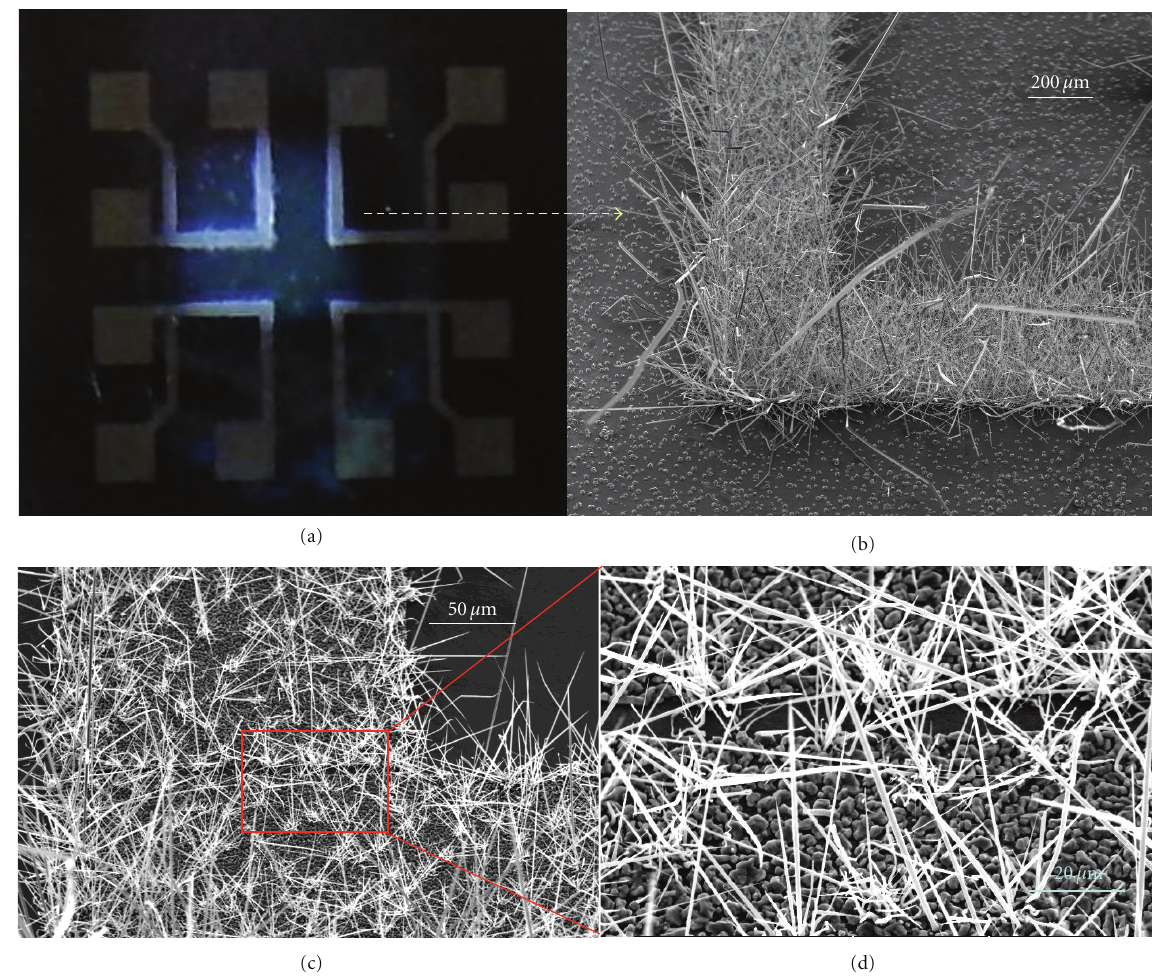
Figure 2: As-grown (a) optical image of 1D ZnO structures deposited area (white) where we have selective deposition around the 10 μ m gap. SEM image (b) with high density ZnO nano- and microstructures, (c) relatively lower density networks on the contacts as well as within the 10 μ m gap, and (d) magnified view of 10 μ m gap part from (c) showing nanowires bridging between Au contact pads.